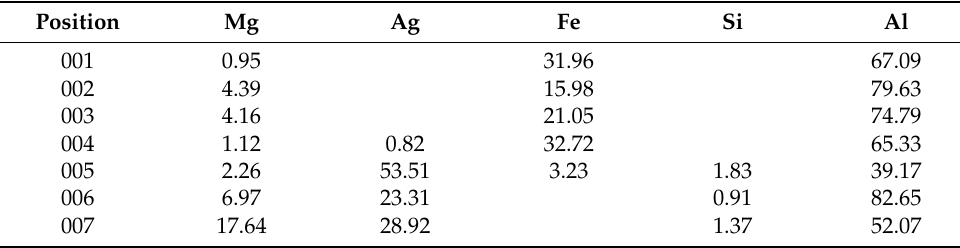
Table 1. Composition of test points as marked in Figure 1